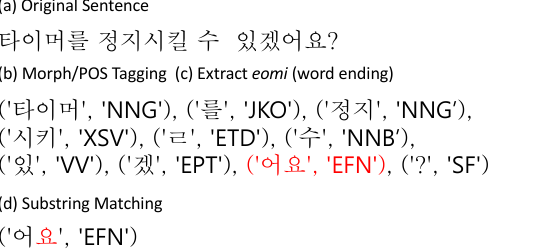
Figure 6. Tagging sentences into honorific or nonhonorific styles. The original sentence (a) " 타이머 ᄅ ᅳ ᆯ ᄌ ᅥ ᆼ 지시 ᄏ ᅵᆯ 수 ᄋ ᅵ ᆻ ᄀ ᅦ ᆻ 어요 ?" (ta-i-meo-leul jeong-ji-si-kil su iss-gess-eo-yo; Can you shut off the timer? ) is segmented into morphologies with their part-of-speech (POS) tags. Then we use ’eomi’s to classify the